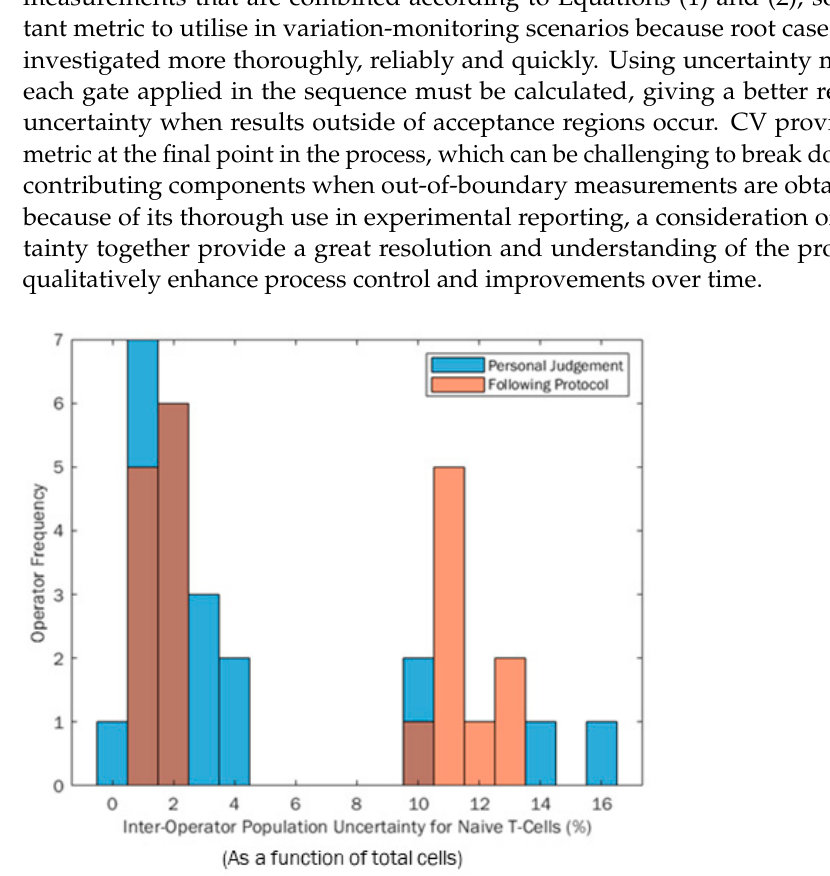
Figure 5. Comparison histograms of participant expanded uncertainties (U) when gating using their own judgement (blue bars) and when following a protocol (orange bars).